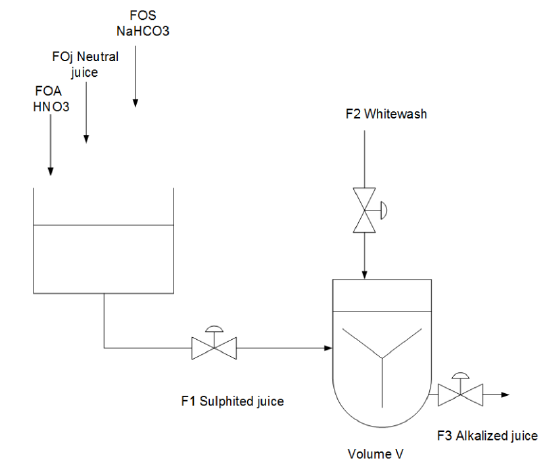
Figure 6. Cane juice alkalinization stage for pH